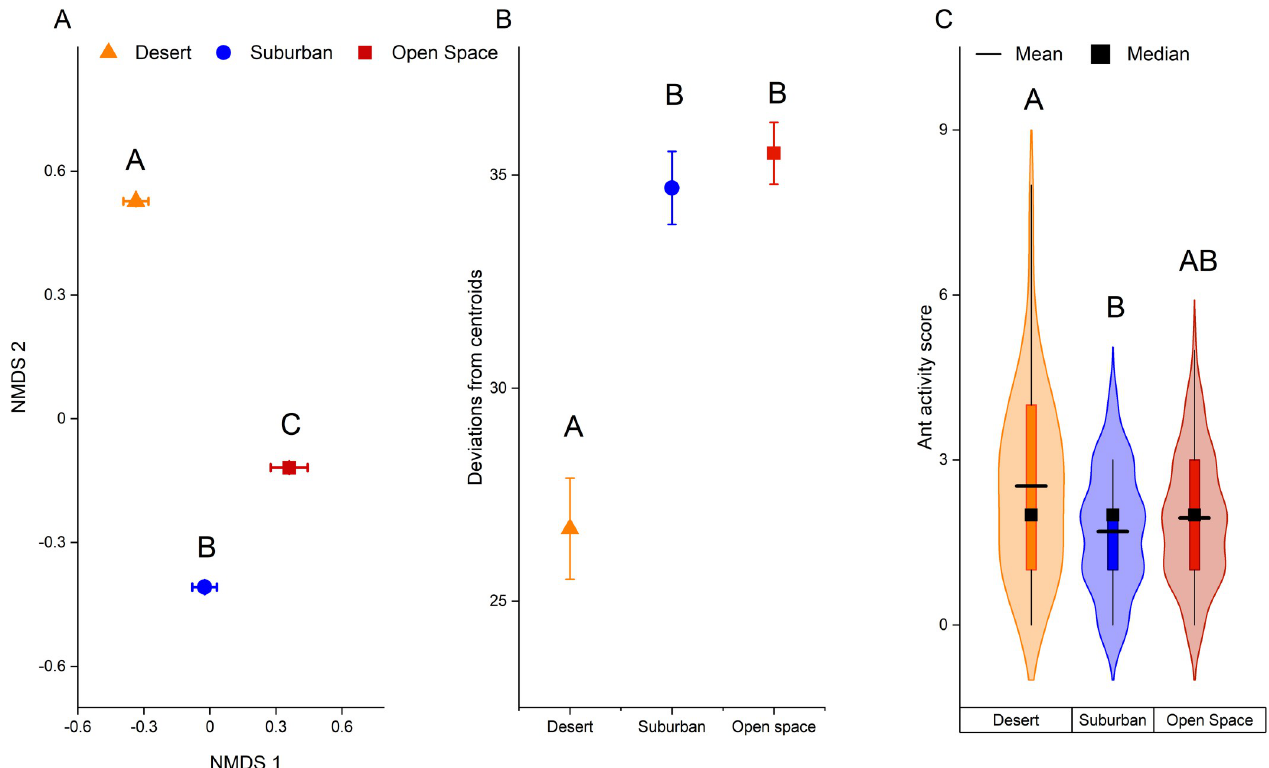
Fig 1. Ant α -diversity, β -diversity, & activity levels across sites with varying levels of urbanization (high = ‘urban’, intermediate = ‘suburban’ and low = ‘wildlands’). (A) Centroids ± 1 SEM from a non-metric multidimensional scaling (NMDS) ordination showing ant species present in response to site type; 2D stress = 0.16, PERMANOVA: P = 0.0001; different letters denote significant differences (post-hoc pairwise PERMANOVA P < 0.05). (B) Mean distance Site type from centroids ± 1 SEM (a measure of β -diversity); Site types had significantly different β -diversity across all sites (Permdisp P ST = 0.0001). Different letters represent significant differences among site types (post-hoc pairwise PERMANOVA: P < 0.05). (C) Violin plot depicting variation in ant activity across sites with varying levels of urbanization. Ant activity was scored on 3 tree cholla segments (1 = 0–9 ants, 2 = 10–19 ants, 3 = 20–29 ants). Horizontal lines represent means while squares represent medians. Inside the box plot is the interquartile range with the tails being the 95% confidence interval. The shaded region is the density probability distributions, given the variability of each group. There was a significant effect of site type on ant activity scores (Kruskal-Wallis test, P = 0.008); site types with different letters were significantly different from one another (post-hoc Dunn test: P <